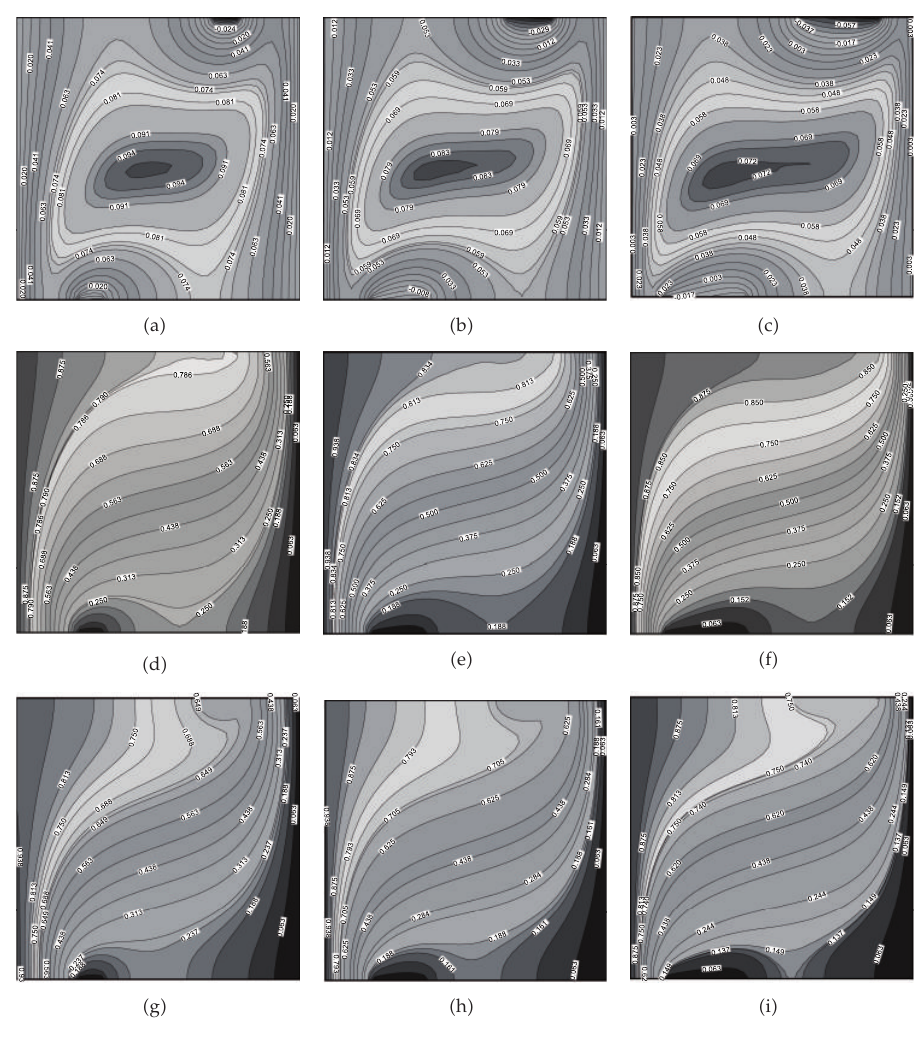
Figure 10: Streamline contours along the left vertical wall while fixing Le (cid:8) 1, B (cid:8) 1, a (cid:8) 0 . 1, Ra (cid:8) 100, S C (cid:8) 0 . 1 for streamline plots (cid:2) a (cid:3) (cid:2) D/H (cid:3) (cid:8) 0 . 1, (cid:2) b (cid:3) (cid:2) D/H (cid:3) (cid:8) 0 . 2, (cid:2) c (cid:3) (cid:2) D/H (cid:3) (cid:8) 0 . 3. Corresponding isotherm and isoconcentration contours are in (cid:2) d–f (cid:3) and (cid:2) g–i (cid:3) , respectively.